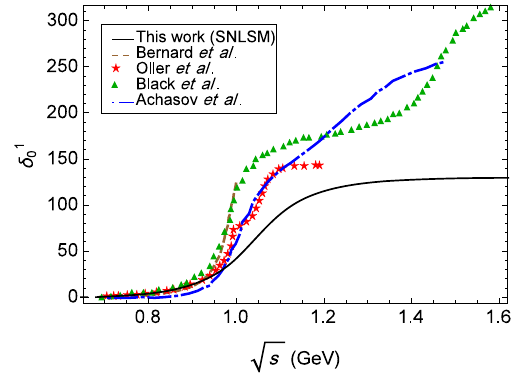
Fig. 5 Phase shift computed from the K-matrix unitarized s-wave amplitude of πη → πη scattering in SNLSM is compared with the predictions by Bernard et al. [147], Oller et al. [155], Black et al. [138] and Achasov et al. [150]. A qualitative agreement is seen up to about 1